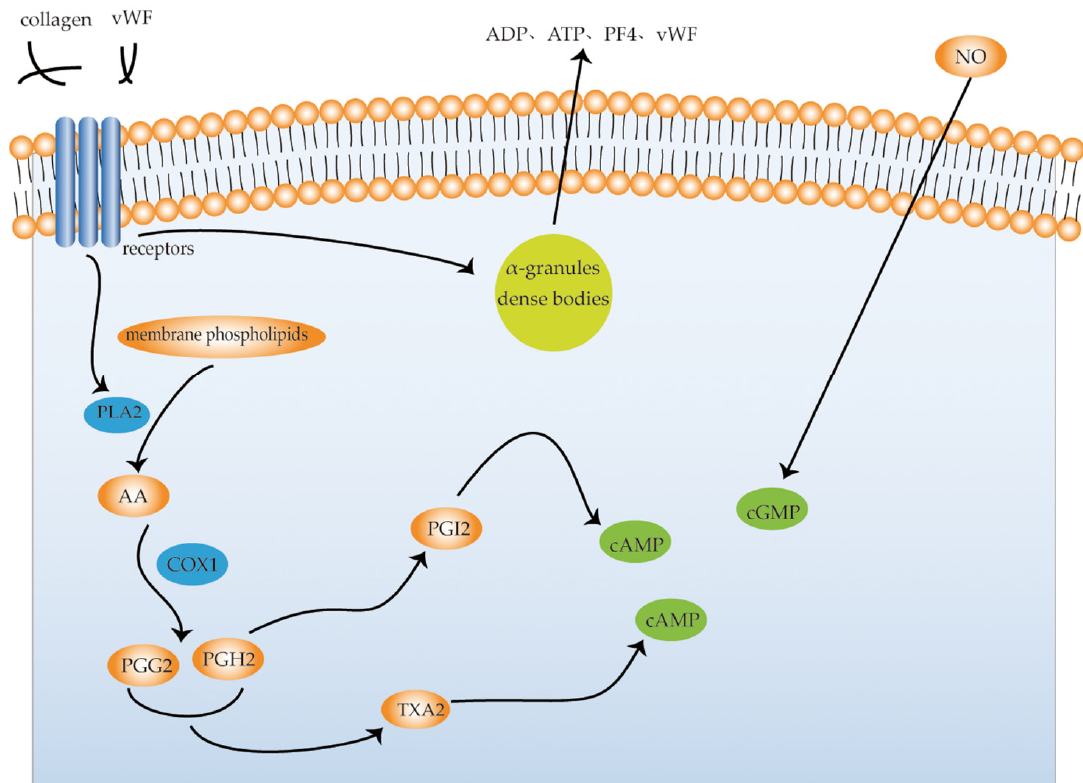
Figure 3. Signaling pathways of platelet activation. vWF, von Willebrand factor; PLA2, phospho- lipase A2; AA, arachidonic acid; PGG2, prostaglandin G2; PGH2, prostaglandin H2; PGI2, prosta- glandin I2; COX1, cyclooxygenase 1; PF4, platelet factor 4.